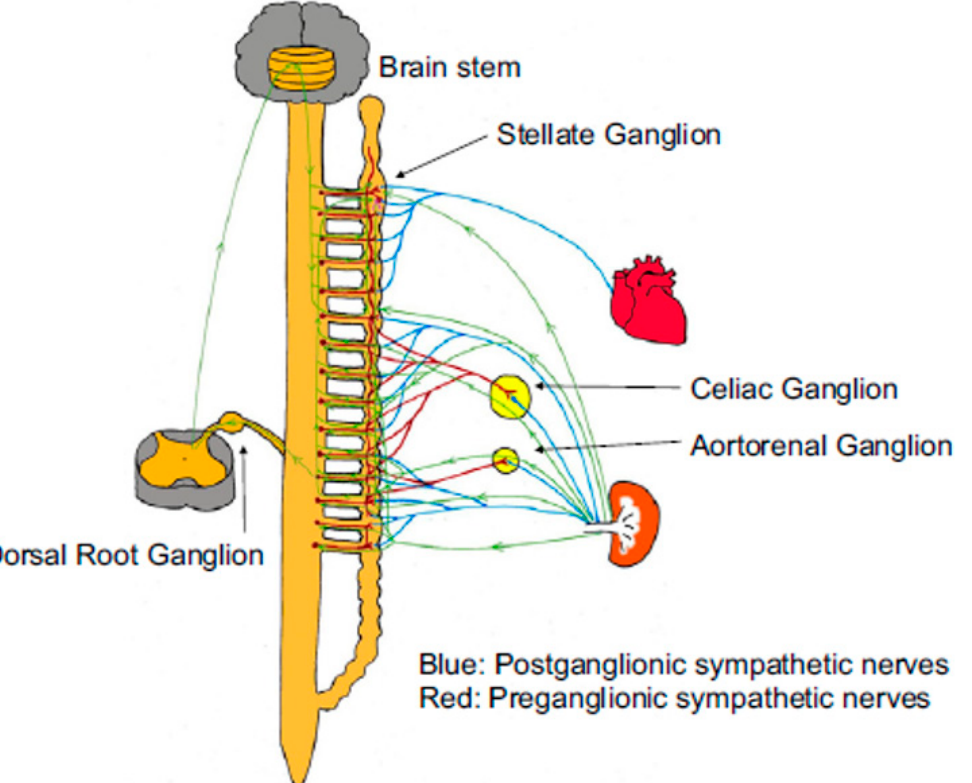
Figure 9. Representations of possible connections amongst different nerve structures [85].